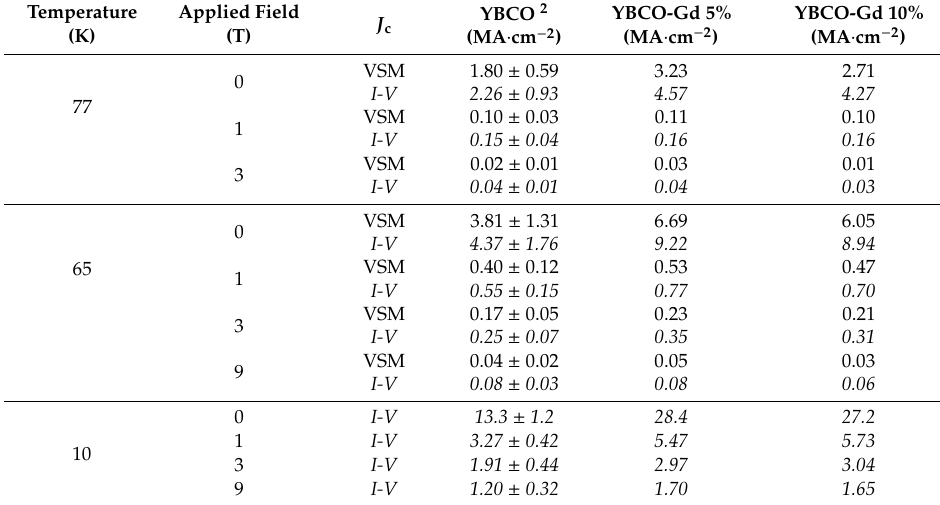
Table 3. Critical current density ( J c ) was measured at di ff erent temperatures and applied magnetic fields. Magnetic and electric transport analyses were compared 1 . Italics is used for I - V data. Films were deposited using the standard